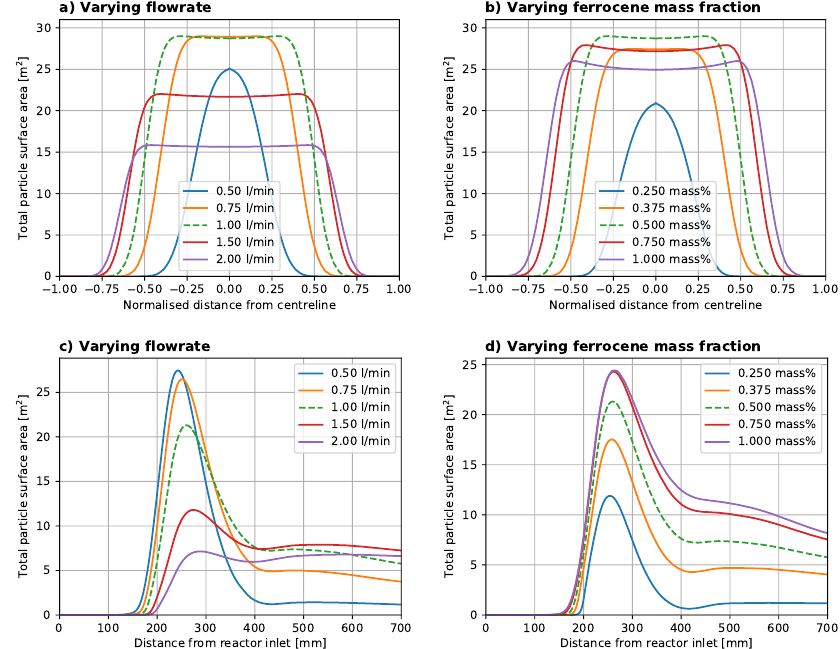
Figure 7. Total particle surface area in the reactor, assuming a monodisperse size distribution: ( a , b ) the radial profile, 500mm downstream from the inlet; ( c , d ) the axial profile, averaged over the radius; ( a , c ) the variations with flowrate (at 1250 ◦ C peak temperature and 0.5mass% ferrocene mass fraction); and ( b , d ) the variations with input iron mass (at 1lmin − 1 and 1250 ◦ C peak